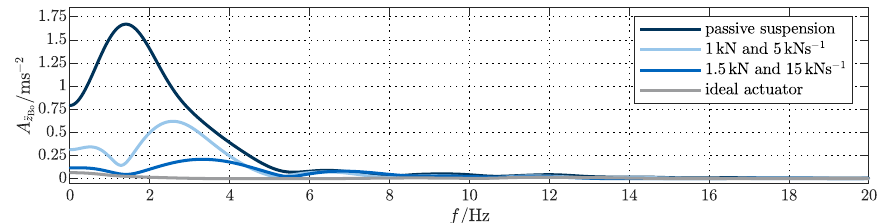
Figure A2. FFT of body acceleration for the bump at 36kmh − 1